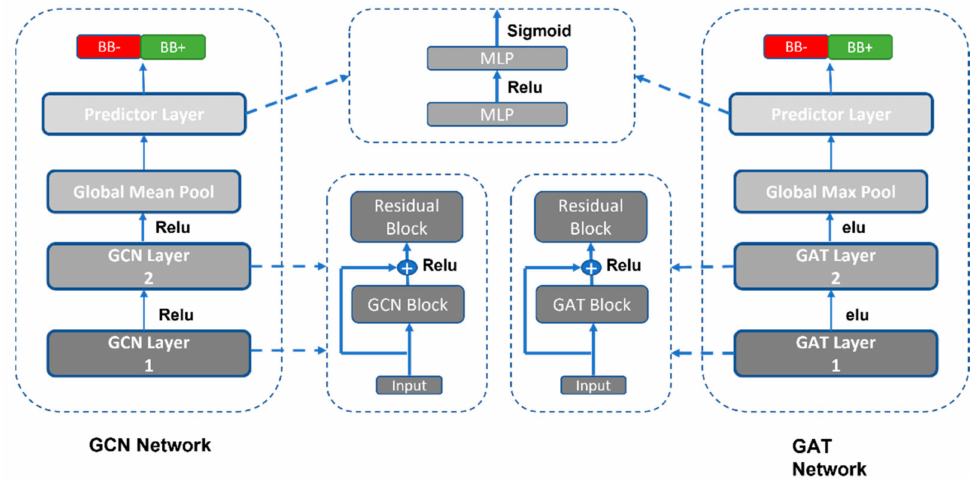
Figure 4. The architecture of the graph neural network models. The GCN and GAT networks share almost the same architecture; the main difference is in their block layer, i.e., the GCN block performs the convolution to learn the low-level representation of the molecular graph, while GAT implements multi-headed attention with convolution to learn the weighted representation of the molecular graph. The GCN network uses a Relu (rectified linear activation unit) as an activation function while GAT implements elu (exponential linear unit) between the layer stacking. Finally, for the downstream task, both implement the same architecture of the predictor layer. The dashed line represents the internal architecture of each block in the